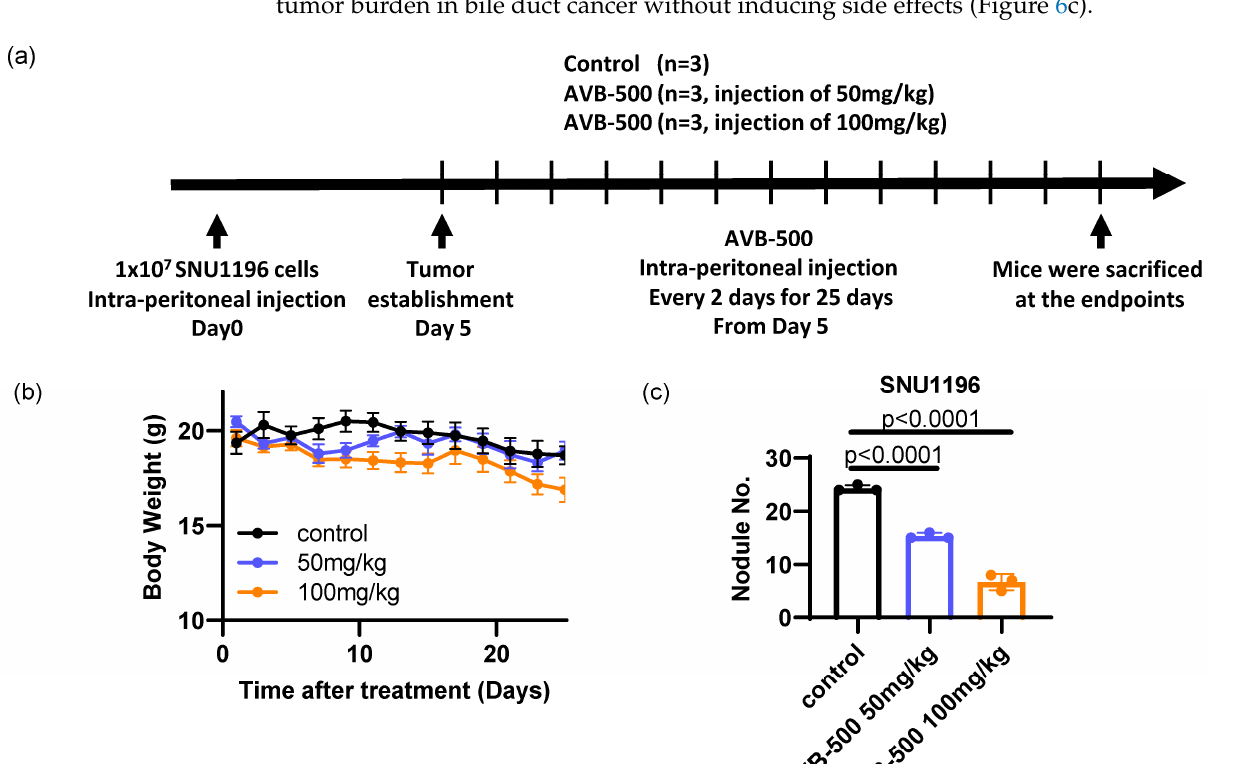
Figure 5. Evaluation of AVB-500, a soluble AXL that is able to decrease tumor growth and invasion in vitro. ( a ) When cells were stimulated with GAS6 after starvation, AVB–500 treatment (0.01, 0.1, 1 mg/mL) decreased phospho–AXL and phospho–AKT expression. ( b ) AVB–500 treatment dose-de- pendently decreased tumor–cell survival (n = 6, two–way ANOVA with multiple comparisons **** p < 0.0001). ( c ) Inhibition of AXL by 1 mg/mL of AVB–500 signi fi cantly reduced tumor–cell invasion in both SNU1196 and HUCCT1 cells (n = 3, student’s t –test p < 0.0001 for SNU1196, p = 0.0003 for HUCCT1)(200 × magni fi cation). ( d ) Scratch assays showed that AXL inhibition by AVB-500 signi fi -